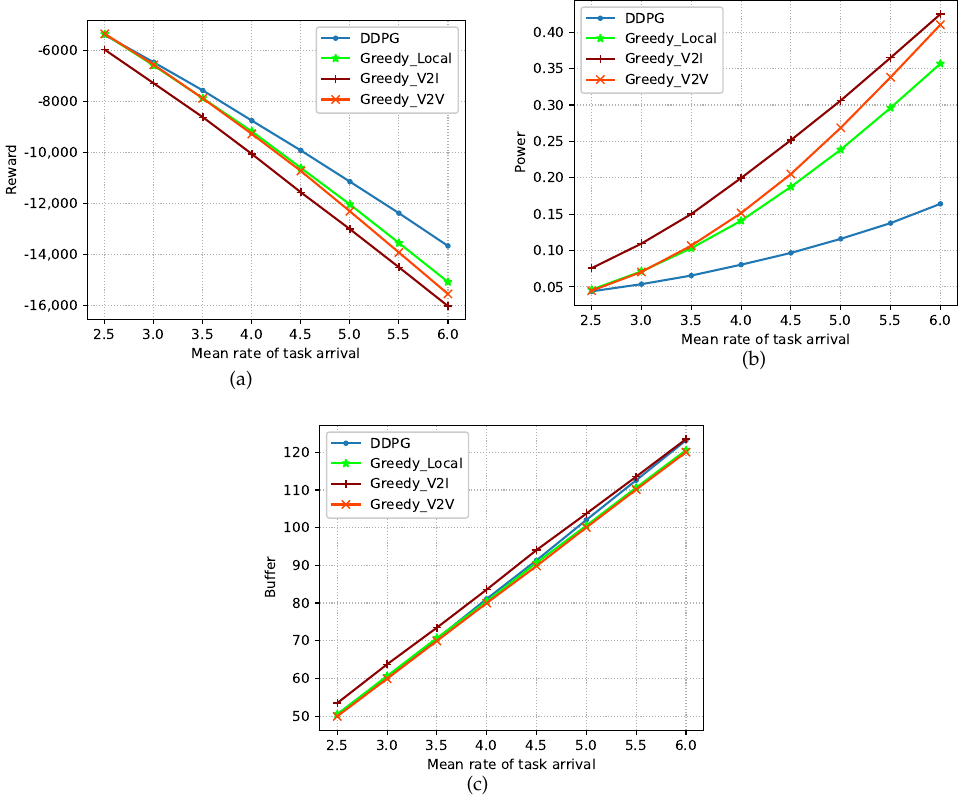
Figure 7. Performance at different task-arrival rates. ( a ) Cumulative discount reward. ( b ) Power consumption. ( c ) Buffer capacity.